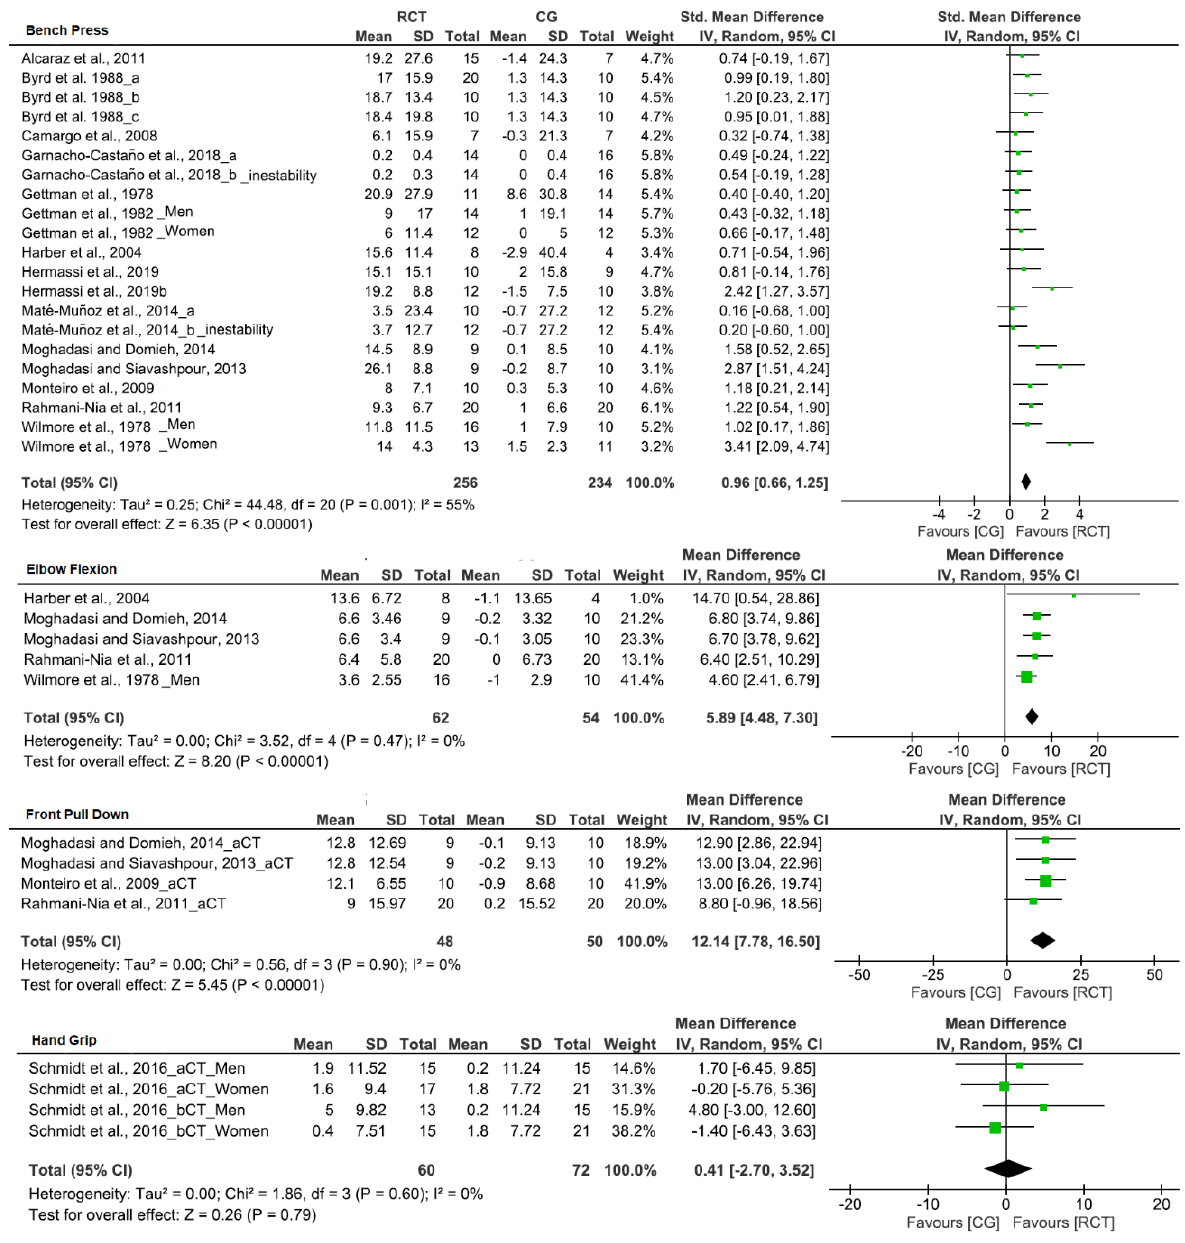
Figure 4. Forest plot showing the results of a random effects meta-analysis for resistance circuit training (CT) compared to control group (CG) on upper limbs exercise .